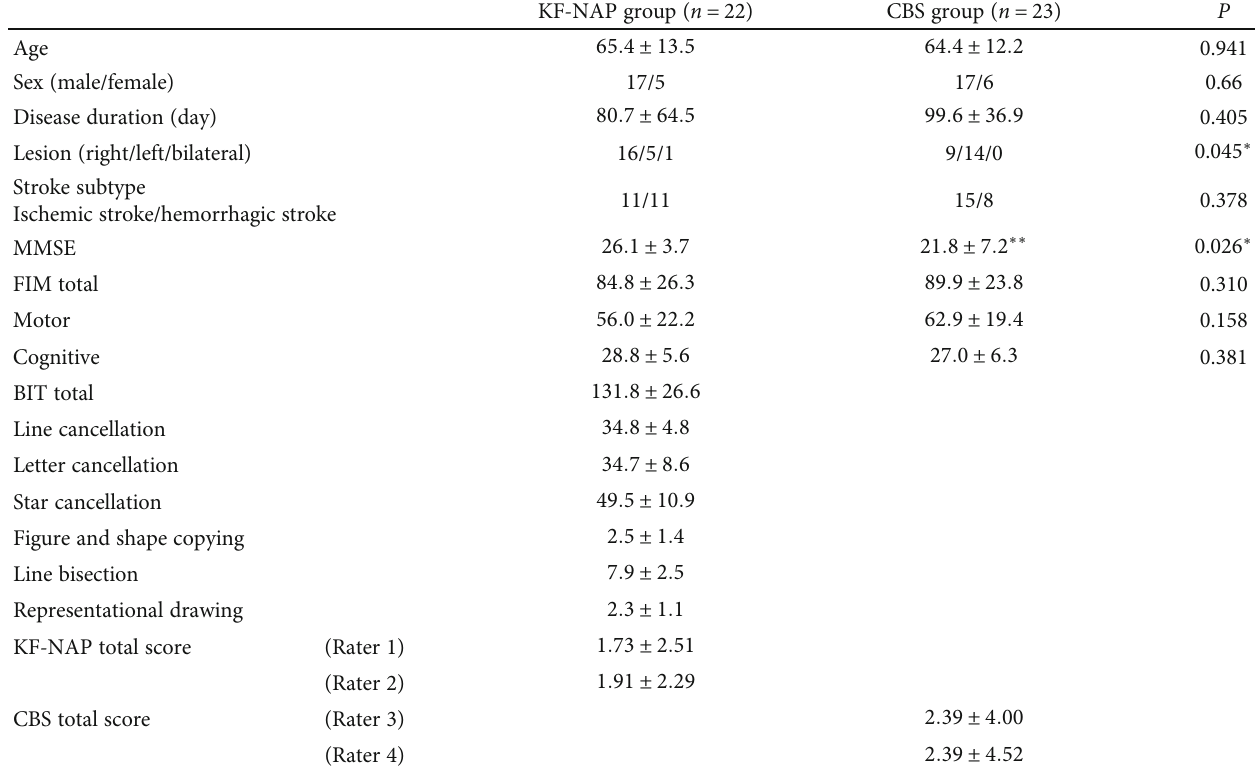
Table 1: Characteristics of the